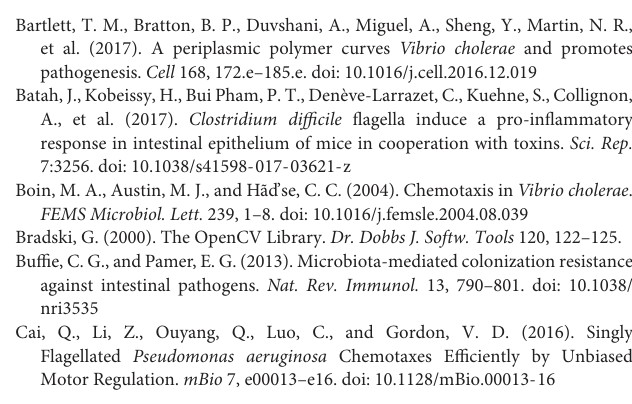
Supplementary Table 1 | Various statistics on individual experiments. Values are given as: average (25 % quantile, median, 75 % quantile). N: number of